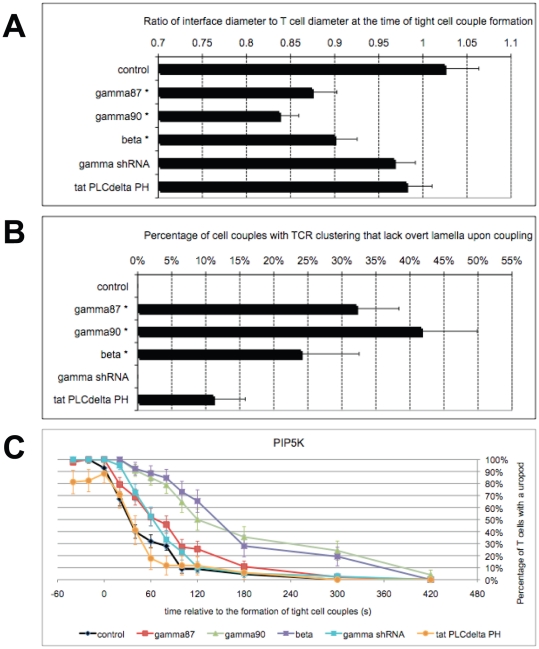
PIP5K overexpression rigidifies T cells.
A. 5C.C7 T cells were activated with CH27 APCs and 10 µM MCC agonist peptide. The diameter of the T cell/APC interface at the time of tight cell coupling is given with standard errors relative to that of the T cell body upon manipulation of PIP5K expression as indicated. An asterisk indicates statistical significance with p<0.01 relative to control. 28–54 cell couples were analyzed per condition. B. 5C.C7 T cells were transduced to express TCRζ-GFP and were activated with CH27 APCs and 10 µM MCC agonist peptide. For all cell couples with persistent interface accumulation of TCRζ-GFP it was determined whether preceding cell coupling occurred with (e.g. Figs. S1C, S2E, and S6A) or without (Fig. S4A, Movie S7) the formation of a visible lamellum. Of all T cell/APC couples with persistent TCRζ-GFP interface accumulation, the percentage of cell couples without visible lamellum upon cell coupling is given with standard errors upon manipulation of PIP5K expression, as indicated. An asterisk indicates statistical significance with p<0.001 relative to control. 25–56 cell couples were analyzed per condition. C. 5C.C7 T cells were activated with CH27 APCs and 10 µM MCC agonist peptide. The percentage of cell couples with a visible uropod is given with standard errors relative to tight cell coupling upon manipulation of PIP5K expression and PIP2 blockade, as indicated. 17–68 cell couples were analyzed per condition.